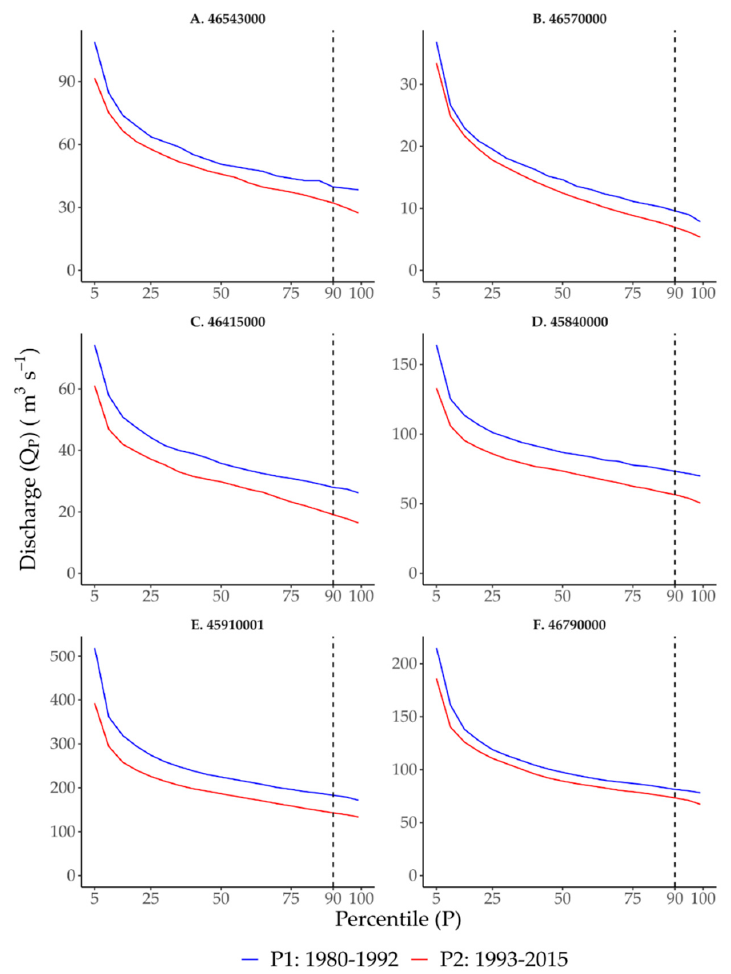
Figure 7. Flow duration curves for stations A – F for periods P1 and P2. Values in the x-axis are the probability that a given discharge (Q p ) is exceeded during that period. The intersection of the dashed line, representing the 90% percentile, and each curve, represents the Q 90 .